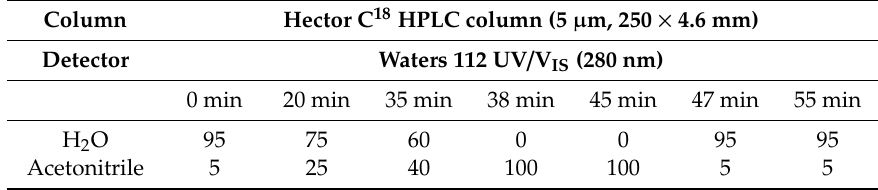
Table 2. Analysis condition of high-performance liquid